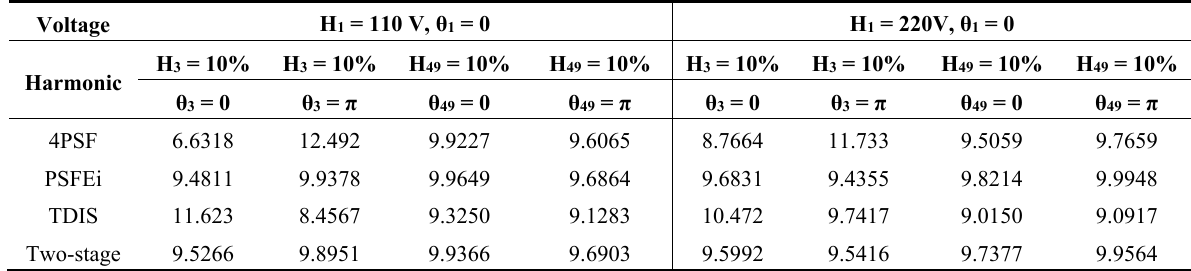
Table 2. Maximum errors of frequency estimation with a fundamental frequency of 60 Hz (10 − 6 × Hz / Hz